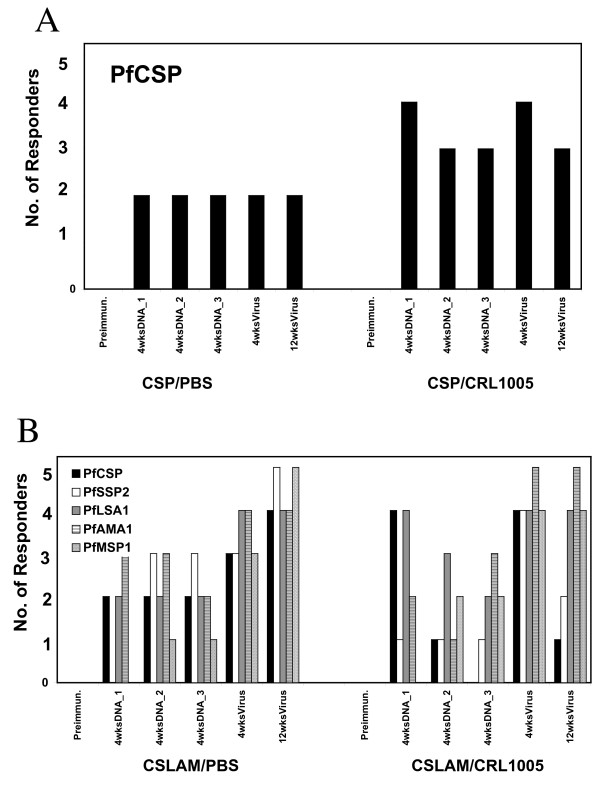
Effect of CRL1005 formulation on frequencies of IFN-γ ELIspot responders in (A) PfCSP or (B) CSLAM immunized monkeys. Monkeys were immunized with either PfCSP or CSLAM in PBS (open circle) or formulated in CRL1005 (solid circle). PBMC were collected at time points as defined in the legend to Figure 2 and assayed against recombinant PfCSP, PfLSA1, PfAMA1 or PfMSP1 protein and PfSSP2/TRAP peptide pools by IFN-γ ELIspot. Data represent the number of animals with responses that met the defined criteria of positivity (SFC = 25 and SI = 2).